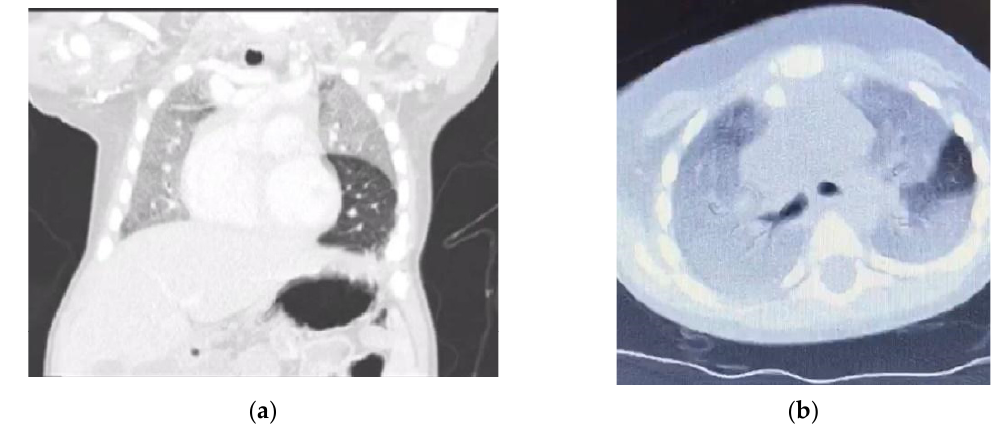
Figure 1. ( a ) CT chest, coronal cut, and lung window with homogenous opacity sparing of lingula but no feature of air trapping or attenuated blood vessels. ( b ) Computed tomography scan chest axial view; lung window ground glass opacity and septal thickening could suggest crazy paving.